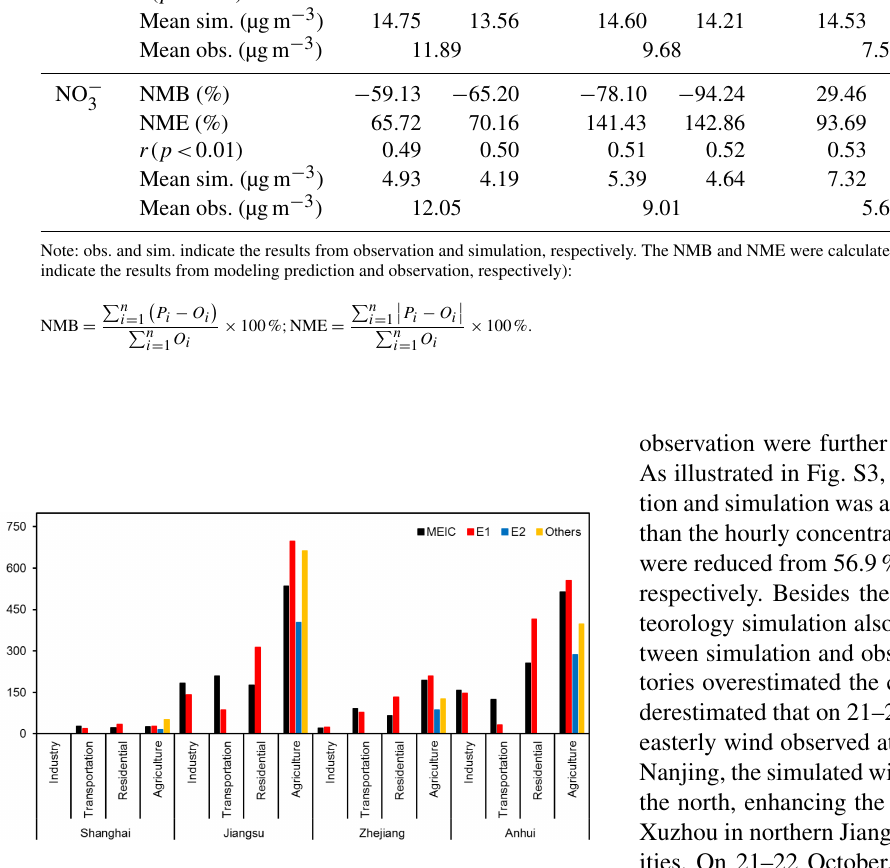
Figure 7. Comparison between the estimated NH 3 emissions in this work and other studies by province and source category. “Others” indicates Fang et al. (2015), Liu and Yao (2016), Yu et al. (2016), and Zheng et al. (2016) for Shanghai, Jiangsu, Zhejiang, and Anhui,